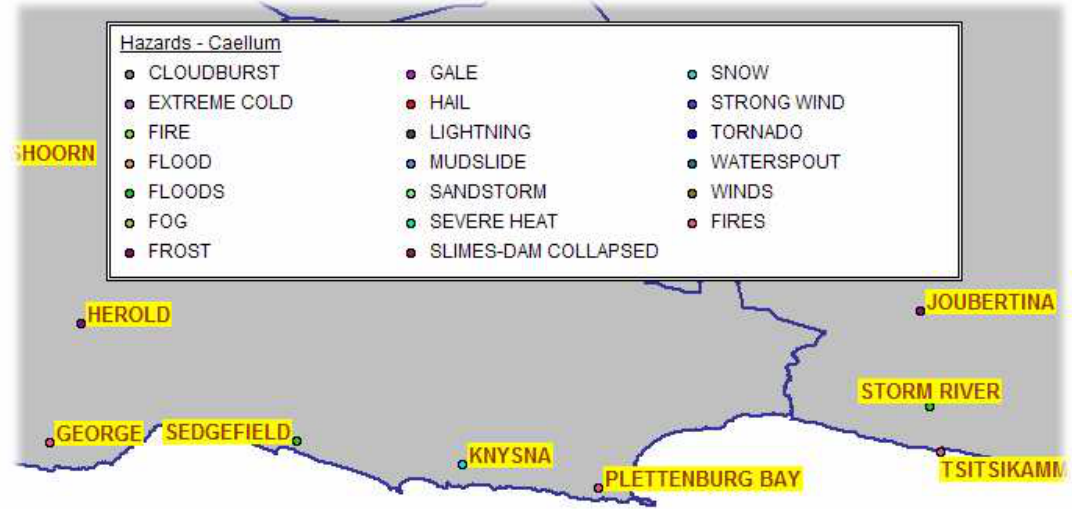
Figure 1: Map indicating the location of hazardous impact events in the Southern